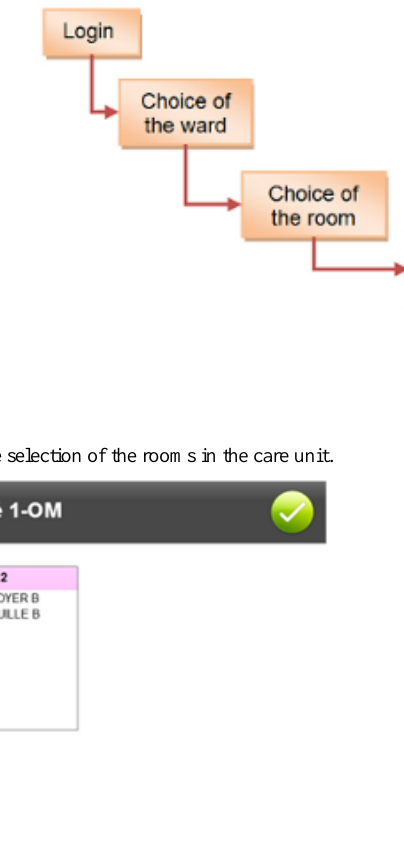
Figure 7. Steps to select the relevant interventions.